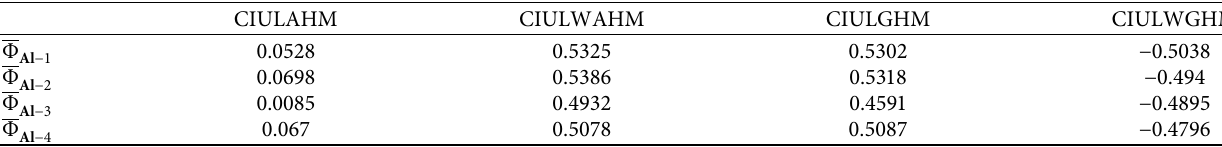
Table 16: Score values of the given alternatives.